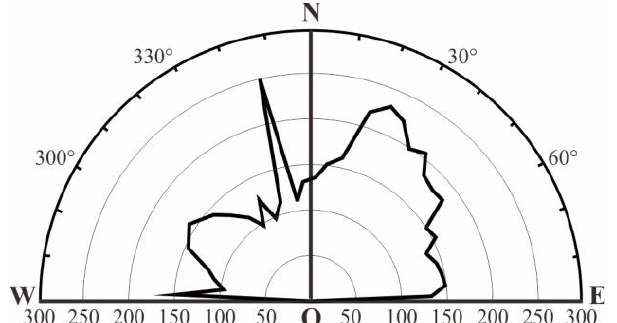
Figure 2. The strike rose